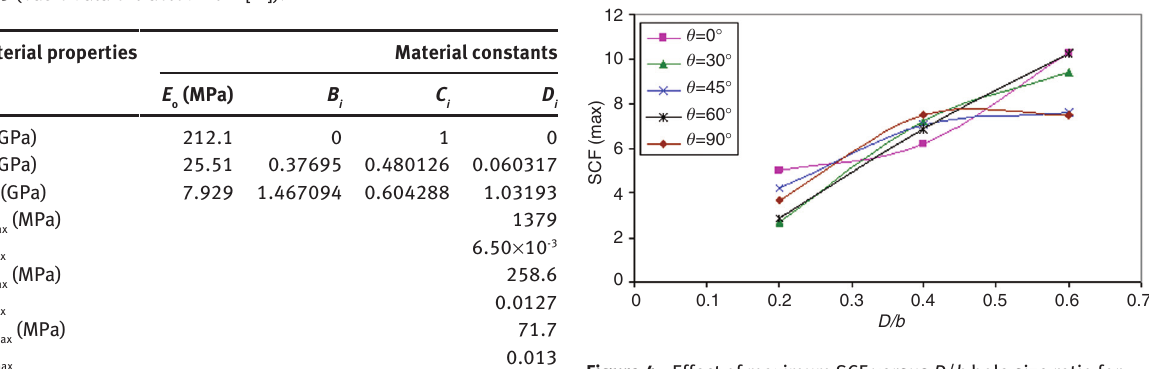
Figure 4 Effect of maximum SCF versus D / b hole size ratio for graphite/epoxy material.